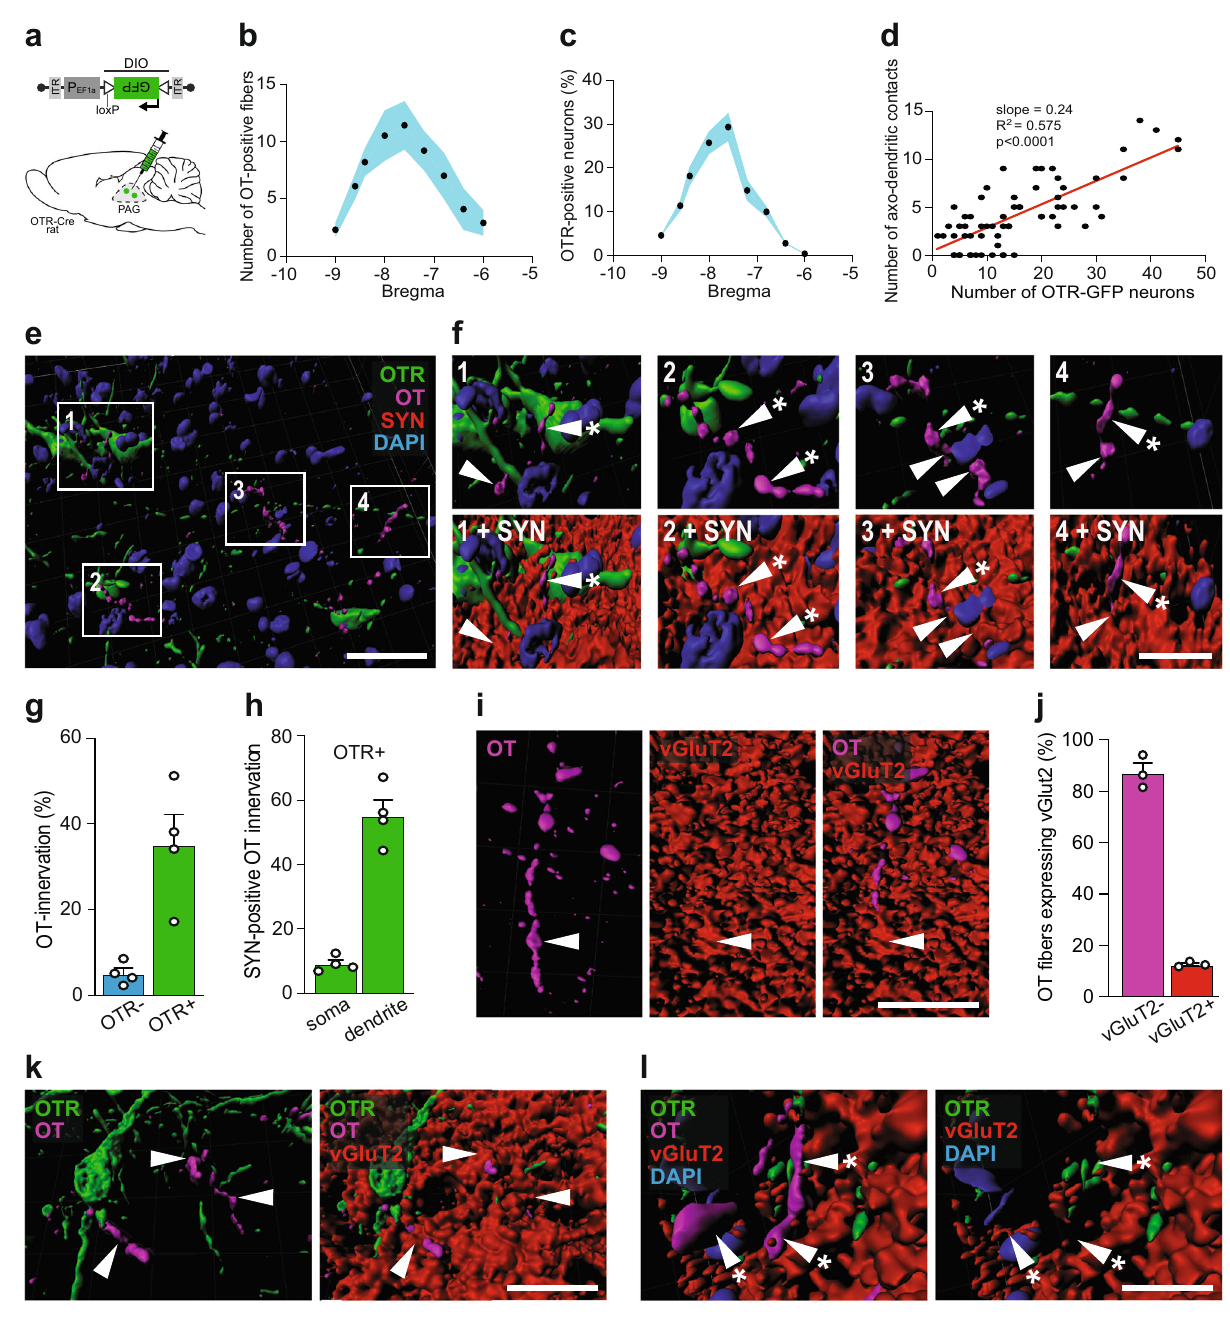
Fig. 3 | OT fi bers form synaptic and non-synaptic contacts with vlPAG OTR neuronsoffemalerats.a SchemaofrAAV 1/2 -pEF1 α -DIO-GFPinjectioninthePAGof OTR-Crerats. b GraphshowingtherelationbetweenthenumberofOT fi bersinthe vlPAG and the bregma level. Blue area represents SEM. n fi bers =290, n rats =4. c GraphshowingtherelationbetweenthepercentageofOTRneuronsinthevlPAG and the bregma level. Blue area represents SEM. n cells =528, n rats =4. d Correlation between the numbers of OTR neurons and OT fi bers within the same slice (n slice = 64). Each dot represents one analyzed brain section. Pearson r correlation, R 2 =0.5745, p <0.0001 (two-sided), slope=0.2438. e , f Three-dimensional recon- struction ofOTergic contacts with vlPAG OTRneurons. e Overviewimage showing OTR-neurons (green), OT- fi bers (magenta), synaptophysin (SYN, red), and DAPI (blue). f Magni fi ed images showing contacts with or without SYN. White arrow- heads indicate co-localization of OT (magenta) and SYN (red), while white arrow- heads with an asterisk show a mismatch of OT and SYN. DAPI=blue, OTR=green.